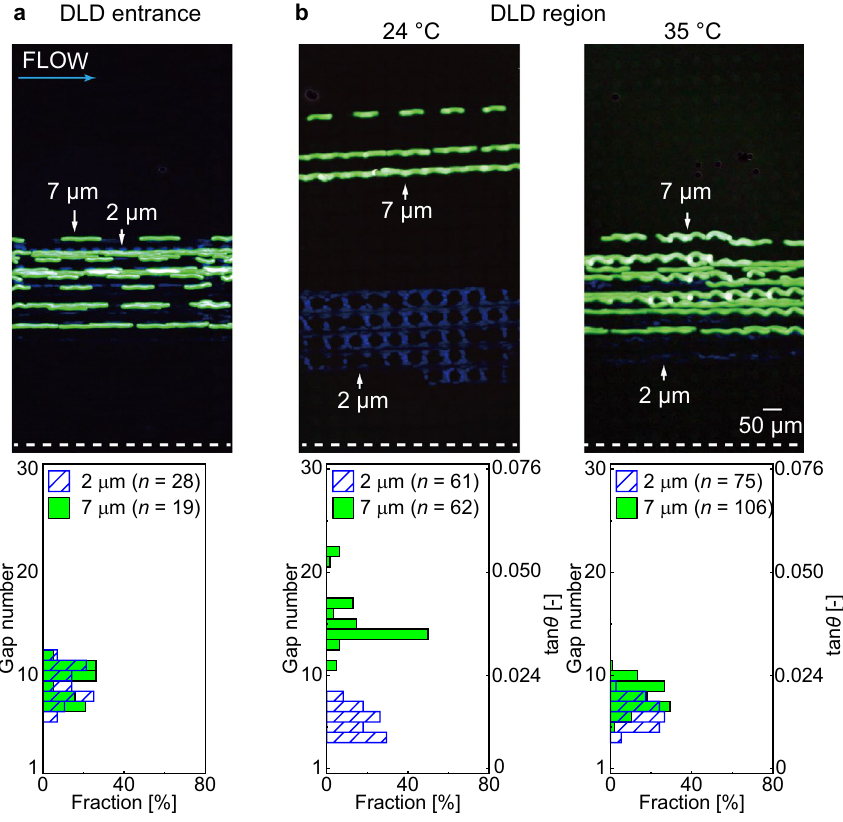
Figure 8. Thermo-responsive on–off operation in the DLD separation of the particles. ( a,b ) Trajectories and spatial distribution of the 7-μm (green) and 2-μm (blue) beads at the DLD entrance. ( b ) Trajectories and spatial distributions of the beads flowing downstream (20th DLD section) at two different temperatures. (left) Separation is ON at a low temperature (24 °C); the 7-μm beads (green) are flowing in displacement mode, and the 2-μm beads (blue) are flowing in zigzag mode. (right) Separation is OFF at a high temperature (35 °C); the 7-μm and 2-μm beads flow in zigzag